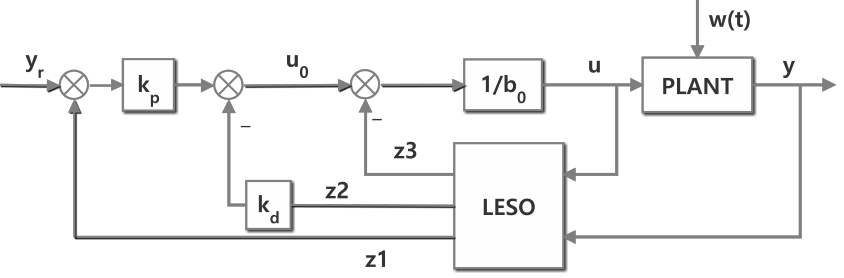
Figure 1. Structural diagram of linear active disturbance rejection control (LADRC).